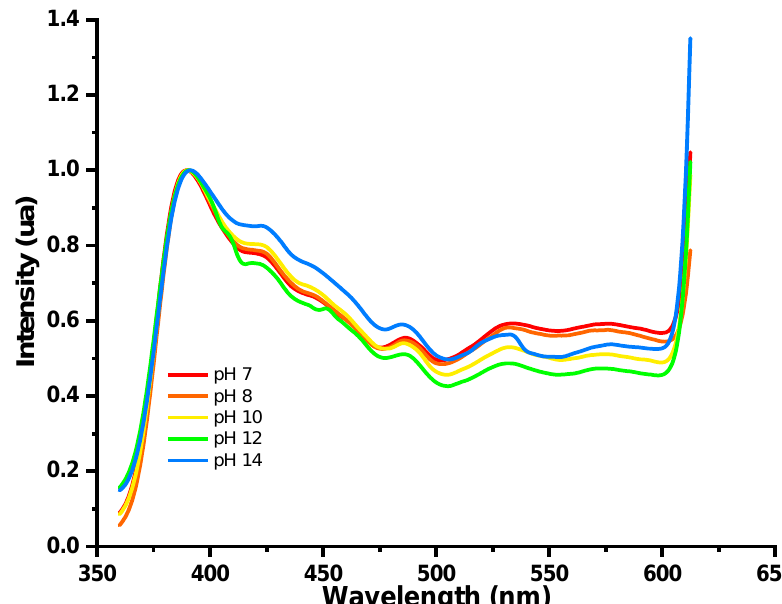
Figure 9. Fluorescence spectra of PDA-ZnO-CMCs-HEC as a function of pH.